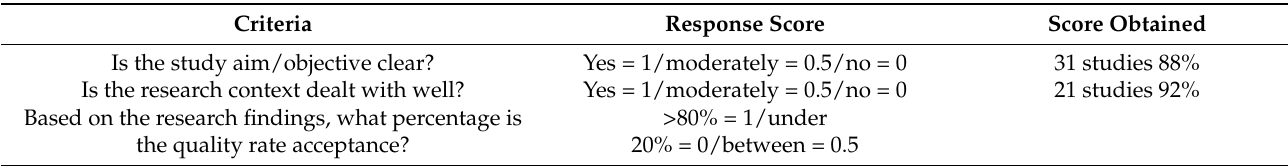
Table 4. Criteria for evaluating the quality of studies.